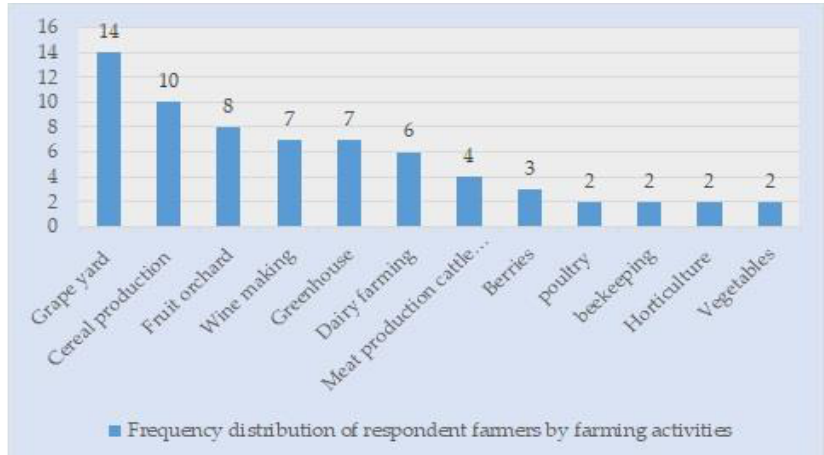
Figure 12. Frequently named farming activities by surveyed farmers.